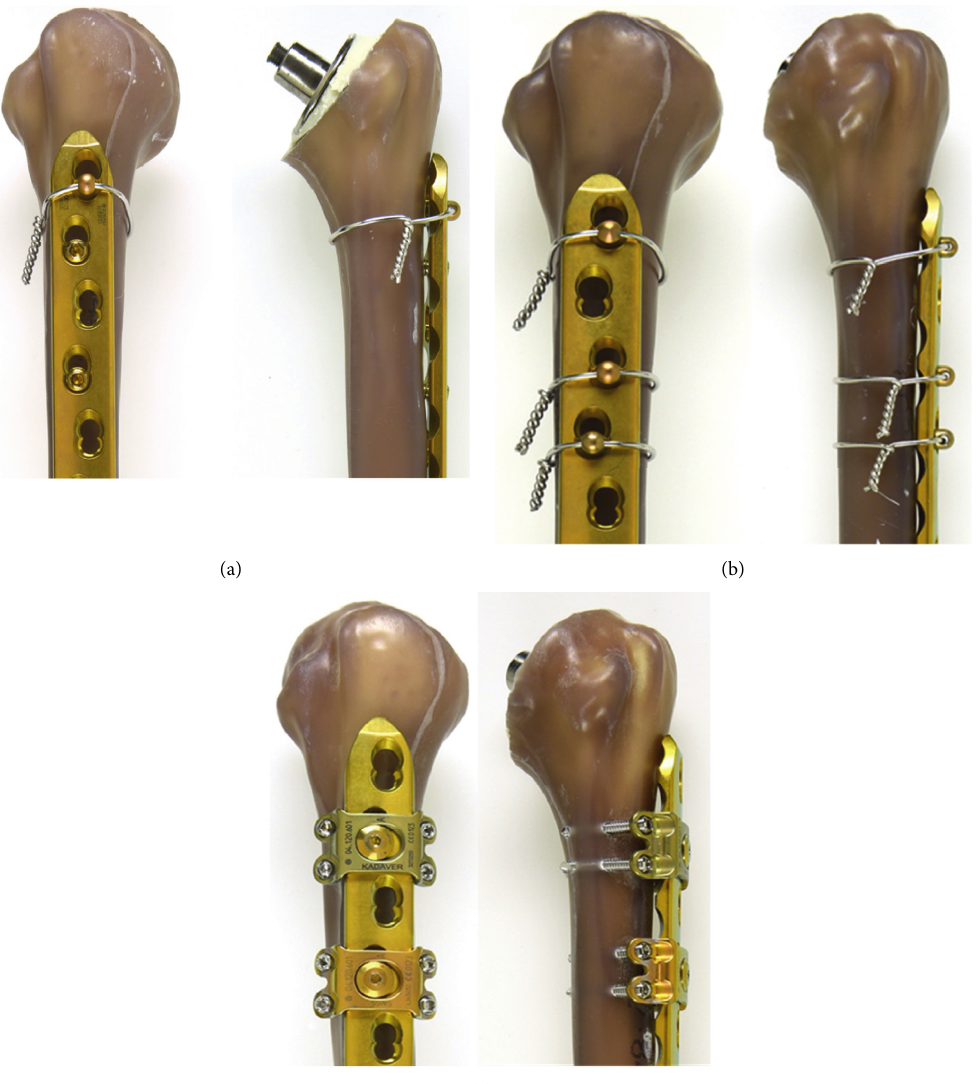
Figure 1: (a). LCP plate fixed on the humerus using 1 × 1.5mm cerclage wires placed at the level of the 1 st hole and 2x unicortical locking screws placed at the levels of the 3 rd and 4 th holes. (b) LCP plate fixed on the humerus using 3 × 1.5mm cerclage wires placed at the levels of the 1 st , 3 rd , and 4 th holes. (c) LCP plate fixed on the humerus using 2x locking attachment plates allowing bicortical fixation placed at the levels of the 2 nd and 4 th